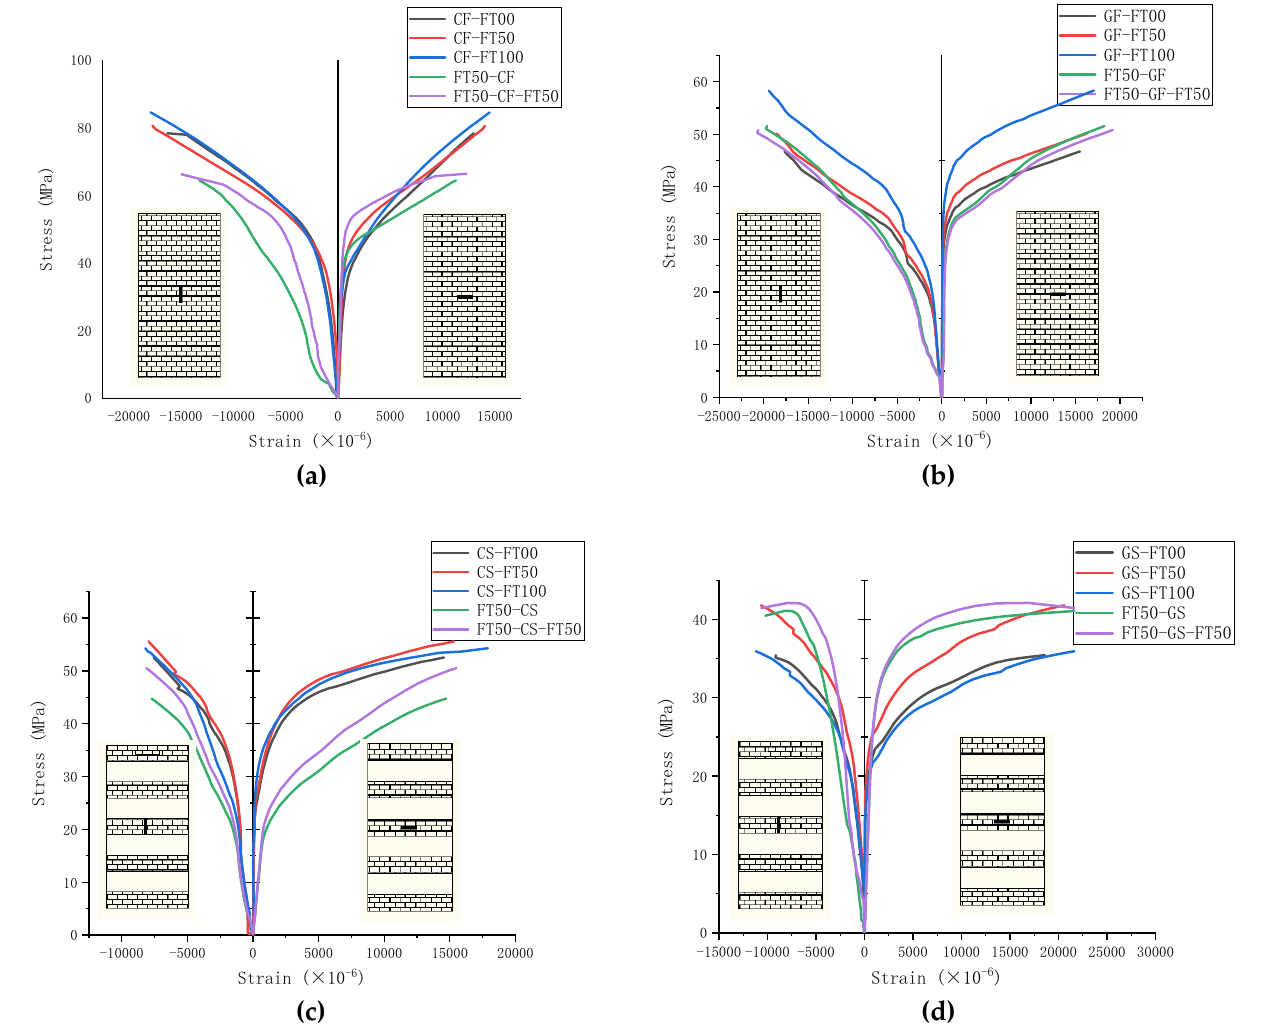
Figure 13. Stress–strain curves of concrete with different confined techniques under coupled erosion : (a) stress–strain curve of CFRP fully-confined concrete; (b) stress–strain curve of GFRP fully-confined concrete ; (c) stress–strain curve of CFRP semi-confined concrete; (d) stress–strain curve of GFRP semi-confined Figure 13a,c show the stress–strain curves of CFRP fully-confined and semi-confined concrete, respectively. The longitudinal strain curve of CFRP semi-confined concrete is steeper than that of CFRP fully confined concrete. This is because the fiber cloth strips in the CFRP semi-confined concrete are separated. Because the confinement force of the fiber strips of CFRP semi-confined concrete is less than that of fully confined concrete. Therefore, the longitudinal strain of semi-confined concrete changes faster in axial compression, and the ultimate strain becomes smaller. However, the ultimate lateral strain is only affected by the material of the FRP itself, so there is no change. Figure 13c stress–strain curve shows that the lateral strain of CFRP semi-confined coagula- tion is very short in the first and second stages and develops rapidly, and the slope is relatively stable in the third stage. It can be explained that the confinement area of CFRP semi-confined concrete is smaller, which is half that of fully confined concrete. As a result, the concrete quickly loses its working ability. It is forced to rely on the lateral restraint force of the fiber layer to reduce the deformation of the specimen. Therefore, the halving of the fiber layer area accelerates the change in strain until failure. The phenomenon of CFRP-confined concrete can also be obtained by comparing the GFRP fully-confined and semi-confined concrete in Fig. 15b,d. Table 5 shows the ultimate stress and strain of FRP-confined concrete and unconfined concrete. The ε ′ cc /ε ′ co is defined with the extension ratio, which can indicate the degree of improvement of the deformation capacity of FRP-confined concrete compared with unconfined concrete. Similarly, the f ′ cc /f ′ co is defined with the enhance- ment ratio, indicating the improvement of the axial compressive capacity of FRP-confined concrete compared with unconfined ordinary concrete. The observation table shows that CFRP fully confined concrete’s confined ratio is the largest, followed by GFRP fully confined concrete, CFRP semi-confined concrete, and post-confined concrete. The extension of GFRP is more significant than that of CFRP, which is related to the elastic modulus